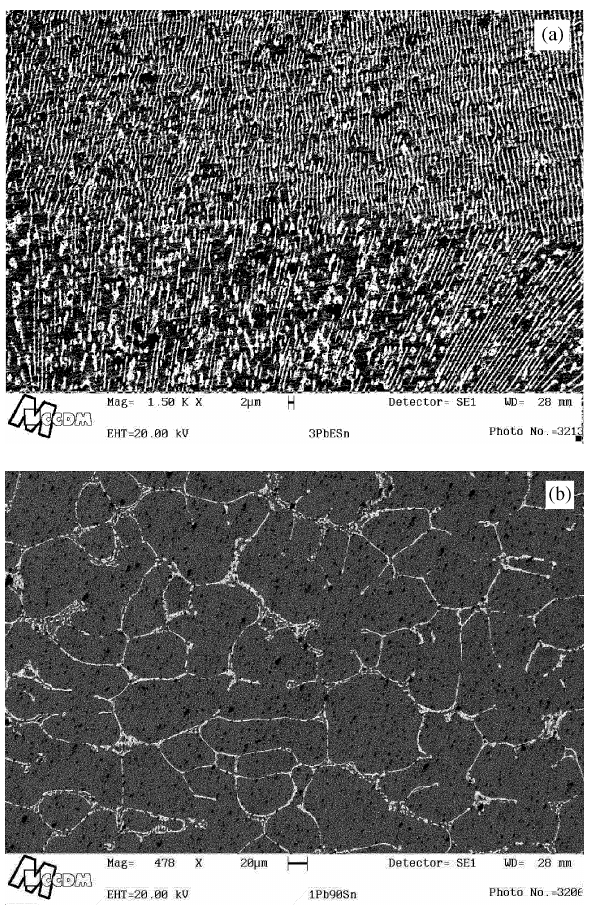
Figure 2. Microstructure of the Pb-25%Sn alloy. (a) Sample A, ∆ T ∆ T e = 7 K; (b) Sample B, e = 13